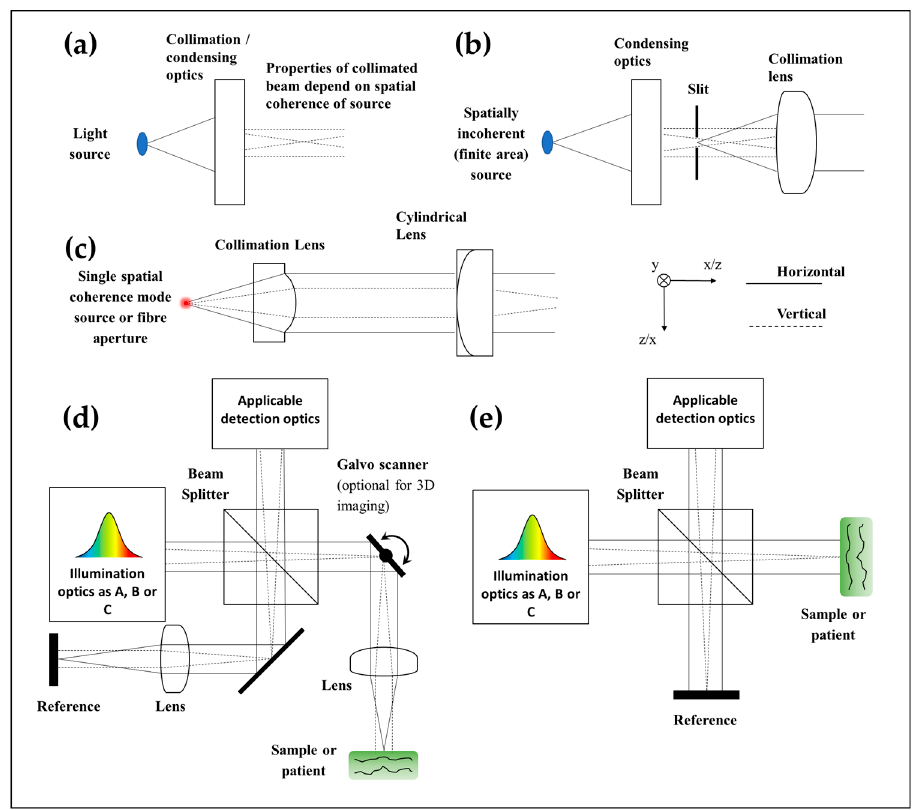
Figure 2. The options for the first (independent of imaging optics) ( a – c ) and second (shared with imaging optics) ( d , e ) halves of the illumination optics. ( a ) Full field (non-confocal) illumination. ( b ) Slit image and ( c ) astigmatic optic generated line field. ( d ) Negatively (see text for description) and ( e ) positively (see text for description) generated line field.